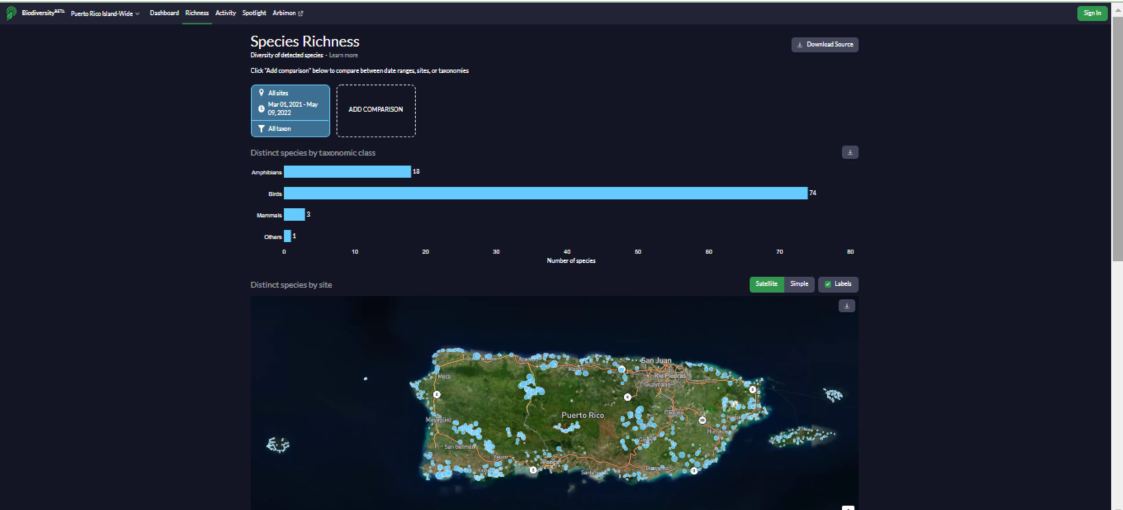
Figure A20. Species Richness: This page presents the results of the number of species detected and allows for exploration of those data in greater detail. The data are presented as a bar graph with aggregated results that can be filtered by region/site, date, and taxonomic group. Below the bar graph is an accompanying map depicting species richness in the selected sites; the point size reflects the number of species detected at each location. Below the map is a graph displaying the number of species according to time of day, day of the week, month, or date.